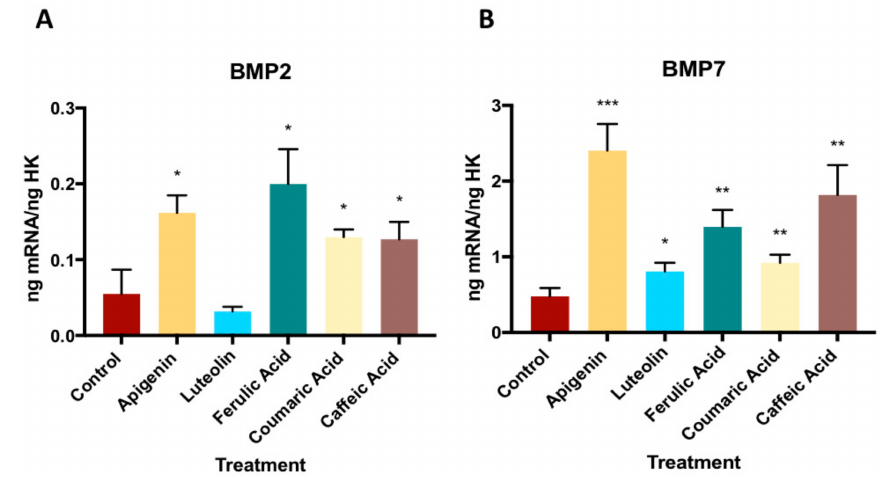
Figure 2. The e ff ect of phenolic compounds on gene expression of BMP2 and BMP7. * p < 0.05, ** p < 0.005, *** p < 0.001. Bone morphogenetic proteins 2 and 7 (BMP-2 and